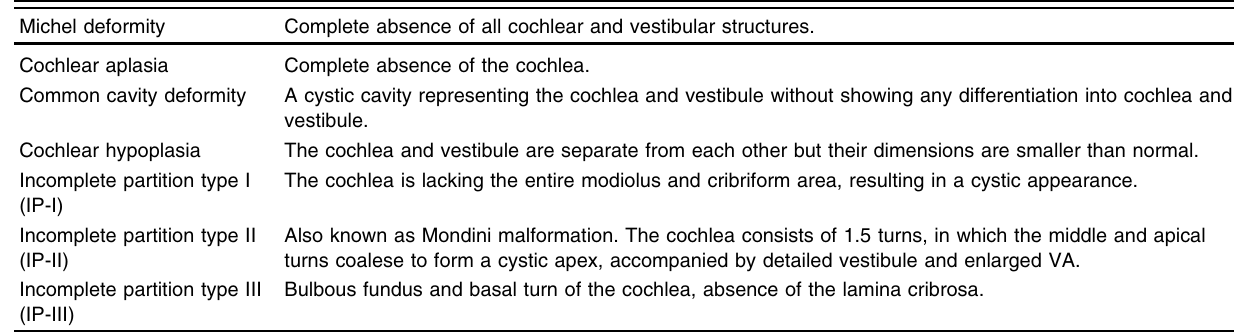
Table 1 Radiologic classification of cochlear malformations Michel deformity Complete absence of all cochlear and vestibular structures. Cochlear aplasia Complete absence of the